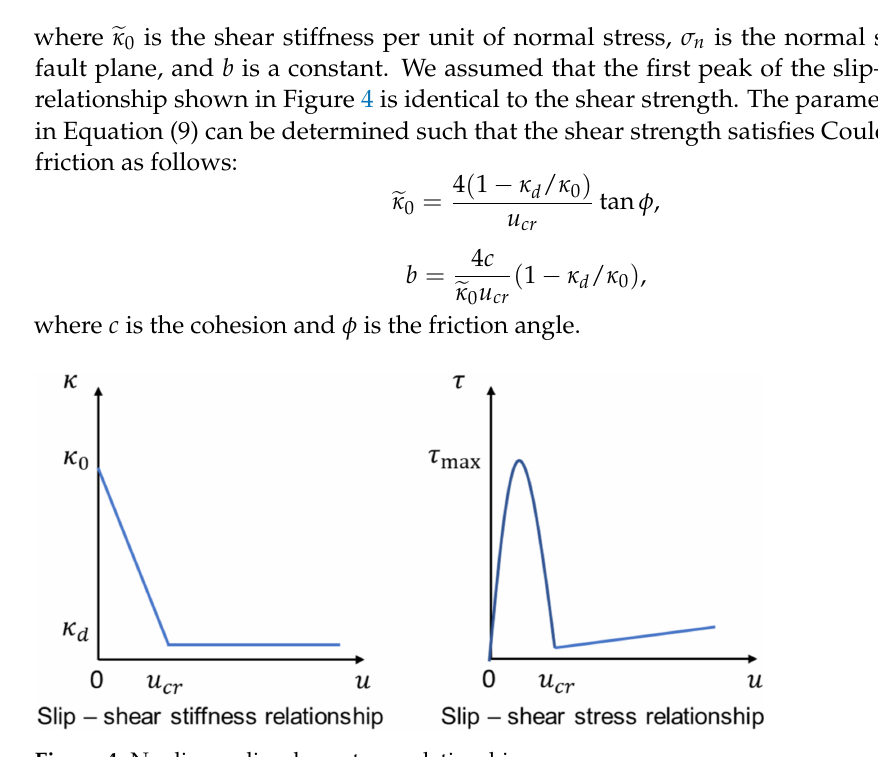
Figure 4. Nonlinear slip–shear stress